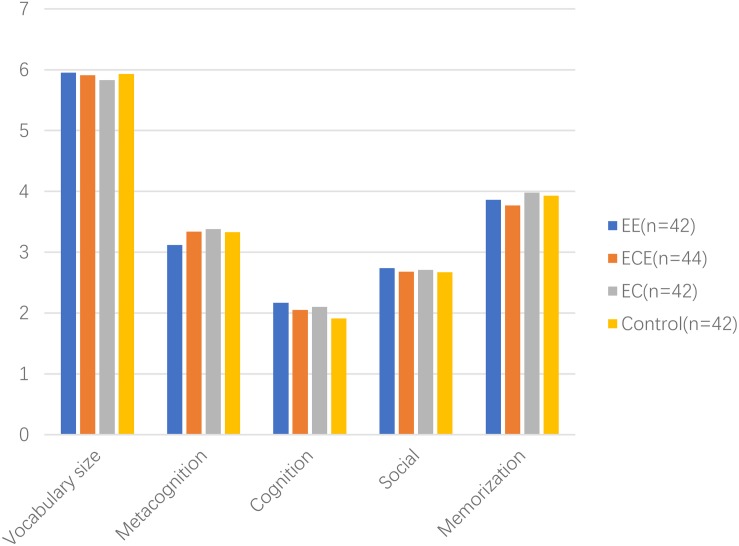
Pre-test results.